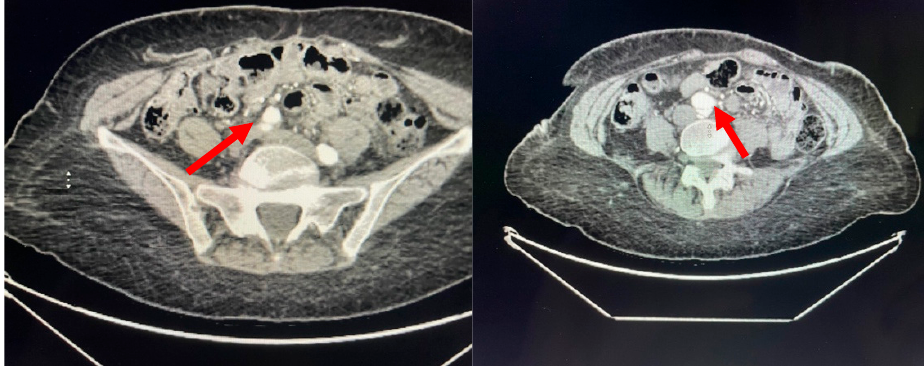
Figure 1. Aortic CTA with runoff. (R) Iliac dissection and false lumen indicated by arrows. Our vascular surgical colleagues repaired these at our institution using an endovascu- lar approach resulting in an excellent clinical